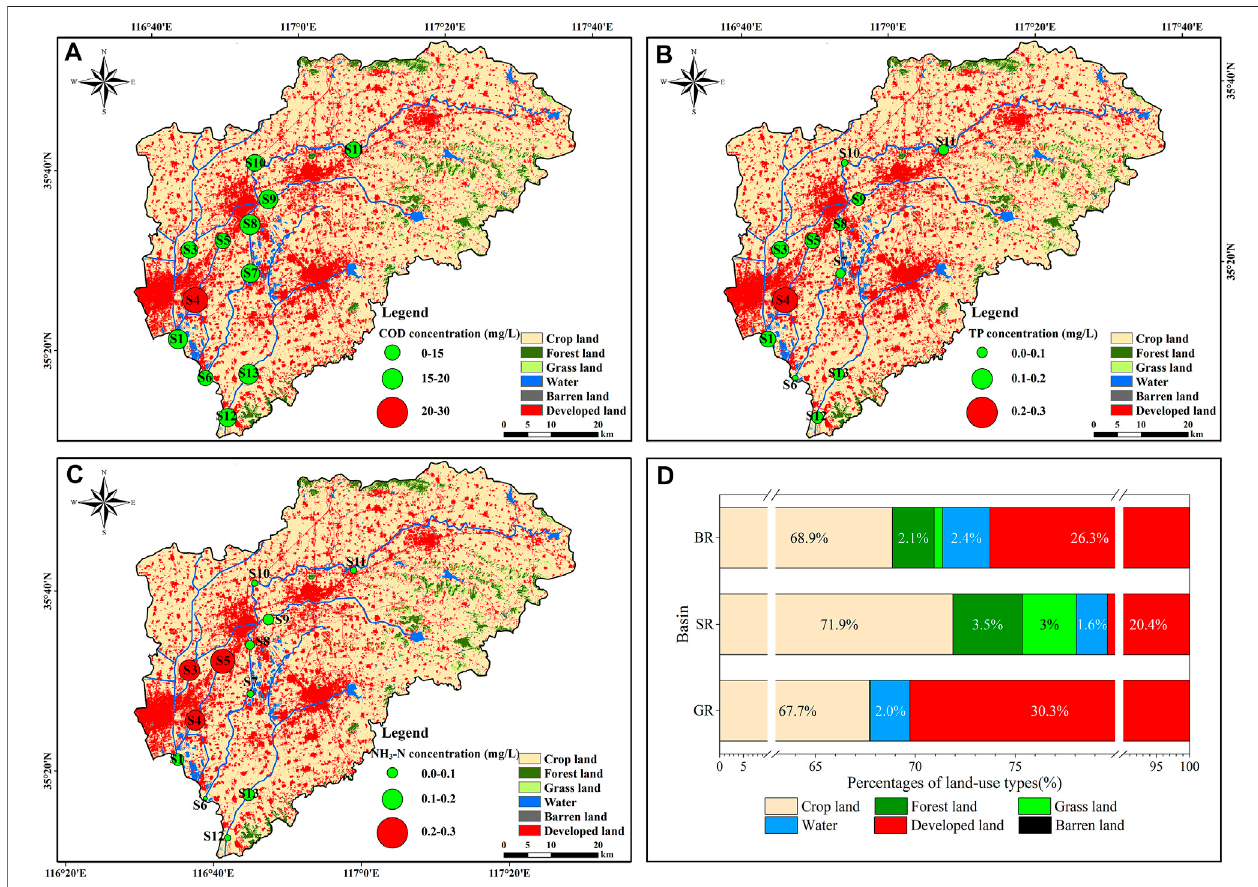
FIGURE 4 | Spatial distribution of average concentrations from 2017 to 2019 (A) : COD, (B) TP, (C) NH 3 -N) and percentages of land-use types in 2018 (D) .